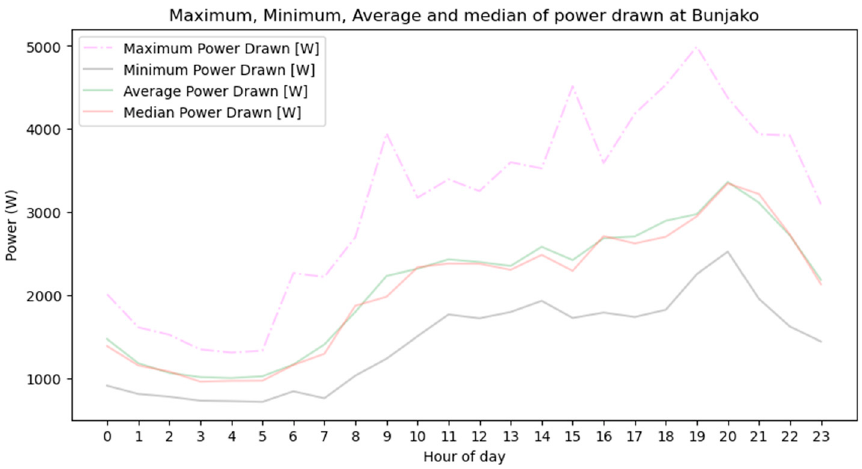
Figure 11. Median, average, maximum and minimum power consumed from Bunjako microgrid (from July to September 2021).